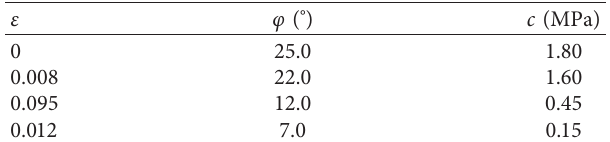
Table 2: Parameter of cohesion and friction angle as functions of plastic strain.